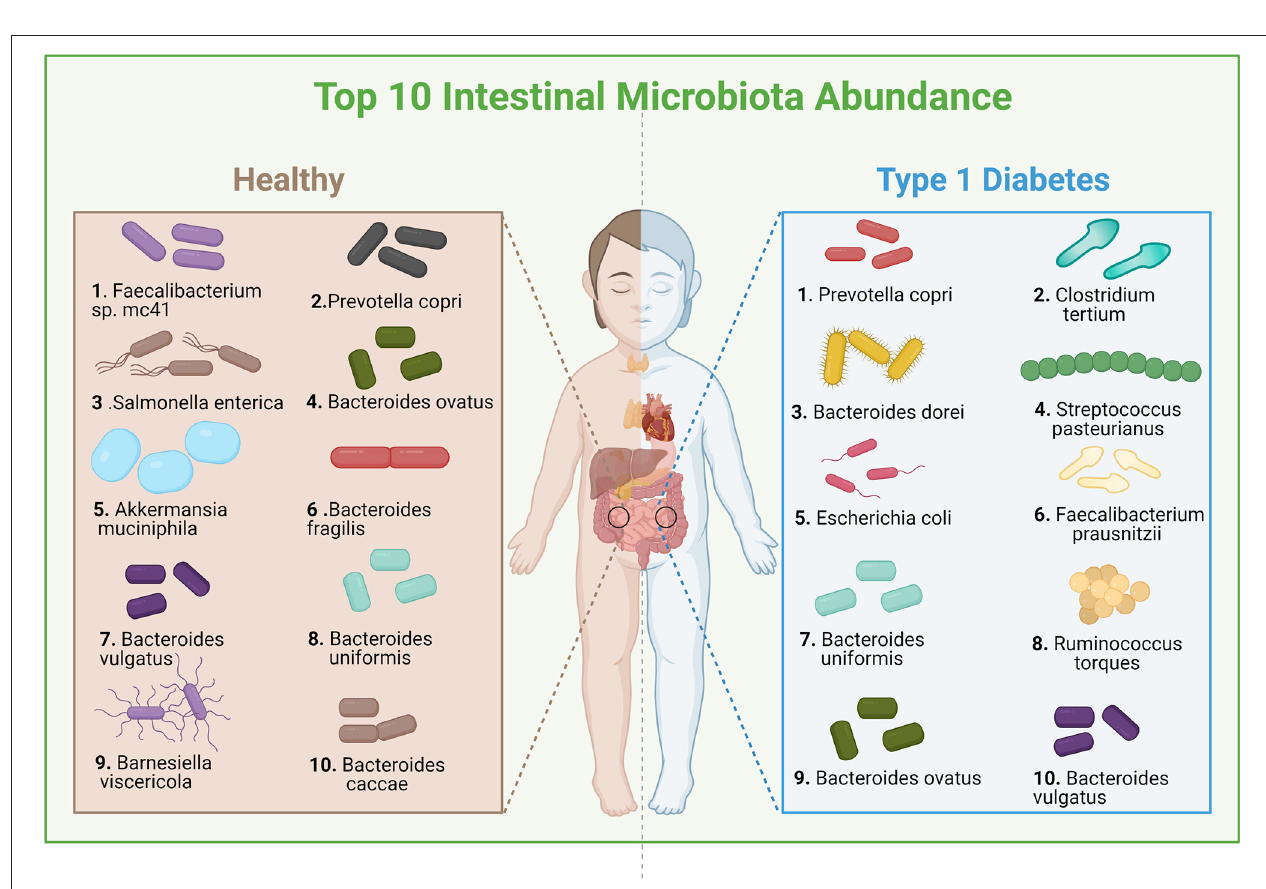
FIGURE 7 | Diversity of flora abundance between healthy and T1D